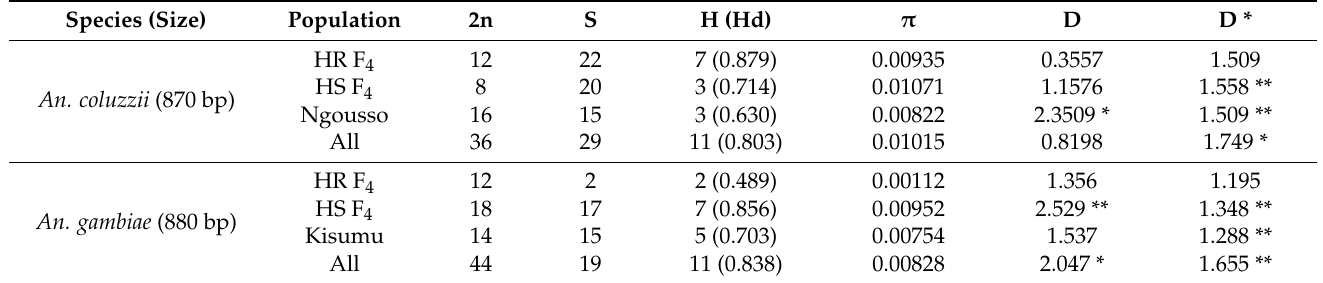
Table 3. Summary statistics for polymorphism of CYP6P4 upstream region in permethrin highly susceptible and highly resistant.